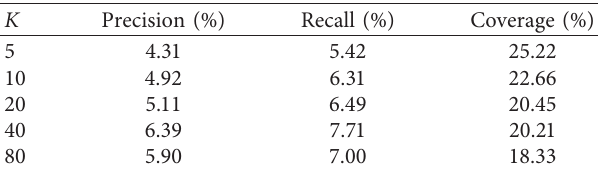
Table 2: User collaborative filtering under different K values based on Jaccard.